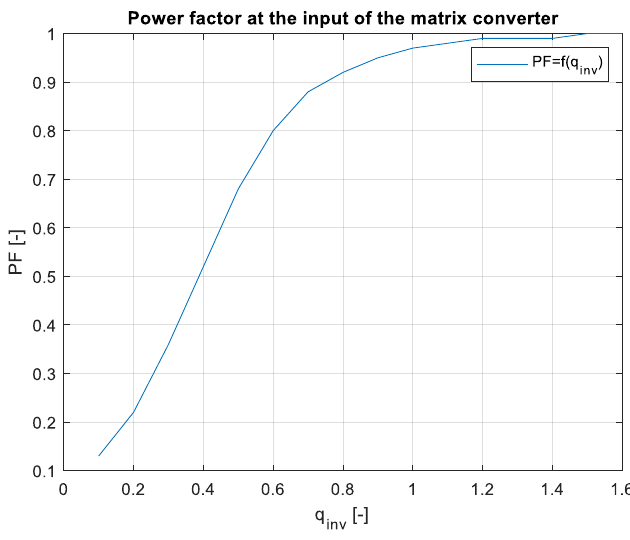
Figure 20. PF at the input of the MxC.